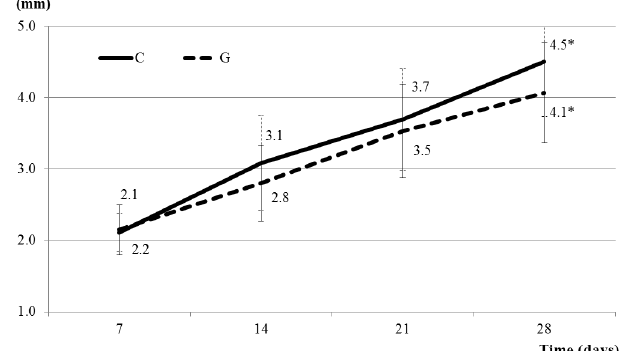
Figure 1. The air cell depth of eggs in the control and experimen- tal groups. The ∗ symbol means that values differ significantly at the p ≤ 0 . 05 level. C represents the control group; G represents the experimental group, treated with a 5% solution of